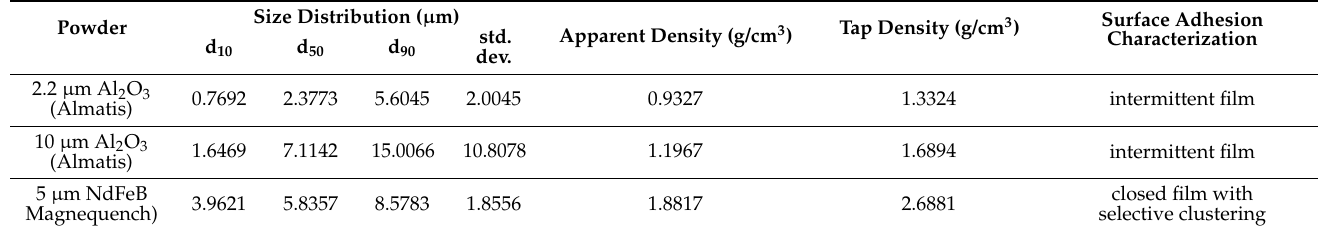
Table 1. Particle size distribution and densities of different powders used for filling experiments.